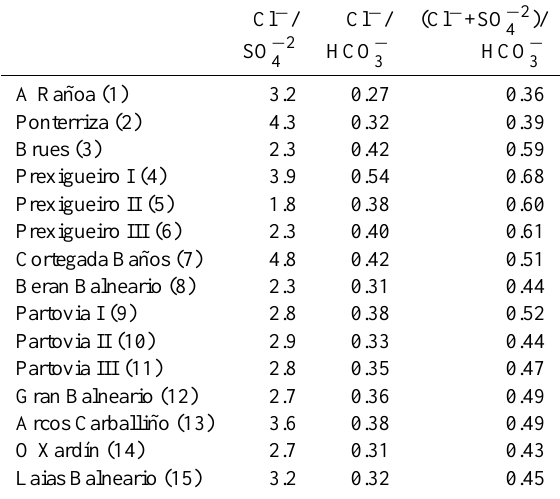
Table 2. Some ionic ratios (in meq l − 1 ) of interest in the selected thermal